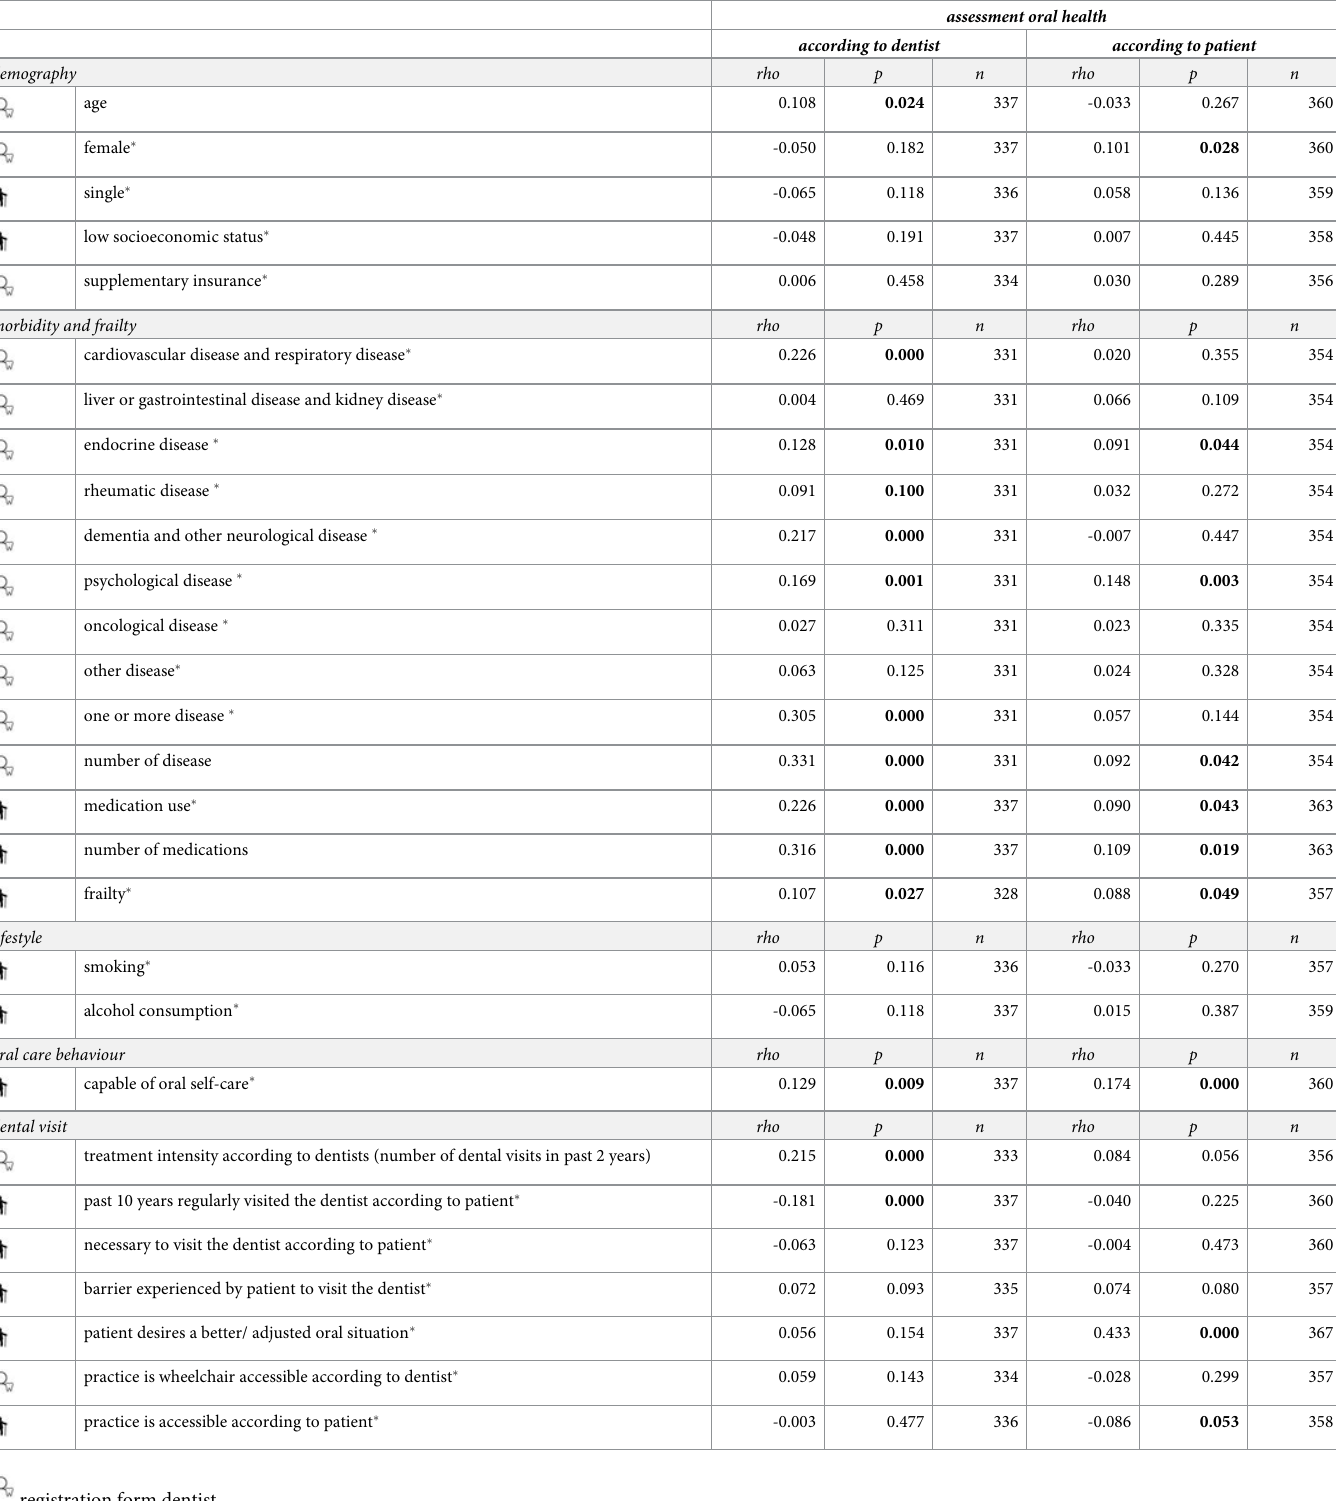
Table 5. Correlation between characteristics of older people who visit the dental practice and the assessment of their oral health, according to respectively dentist and